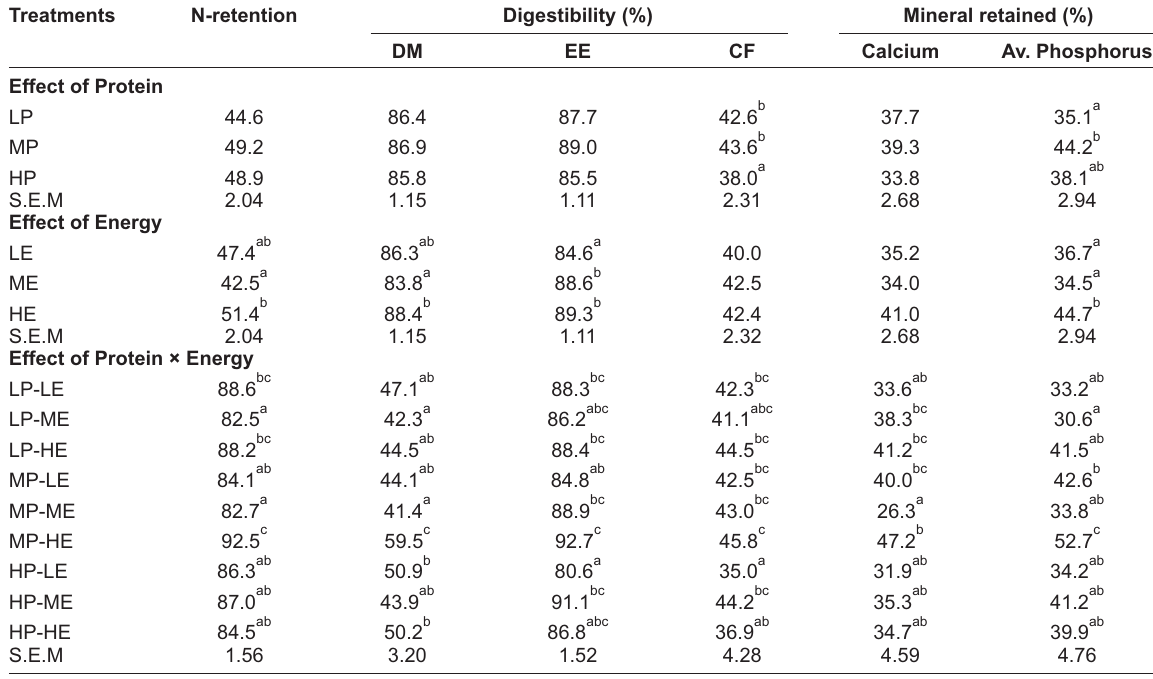
Table-3: Percent nutrient utilization at different levels of protein and energy